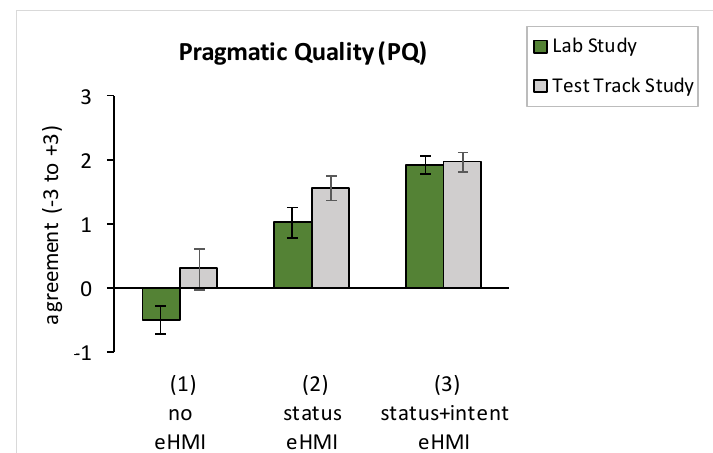
Figure 11. Pedestrians’ Pragmatic Quality (PQ) ratings of the three eHMI variants (test conditions 1, 2, 3) in this lab study and in the test track study of Faas et al. [12]. Error bars: ± 1